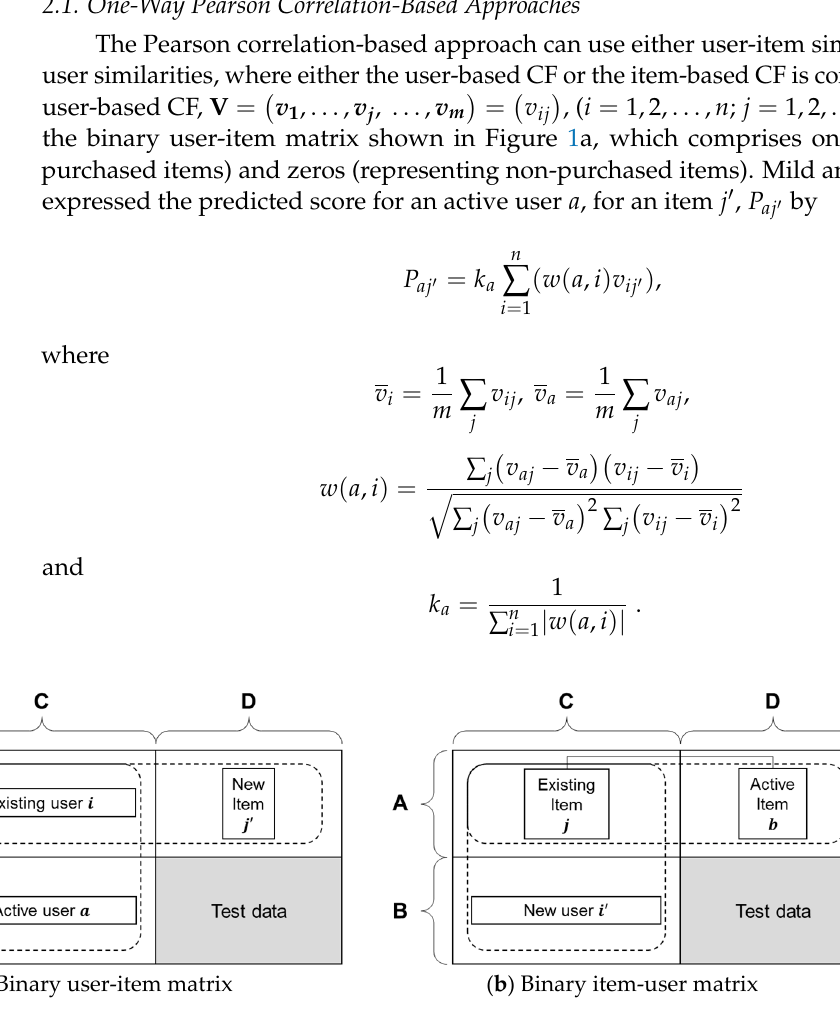
Figure 1. Two types of matrices for the CF. (A: existing users, B: active users, C: existing items, D: active items).